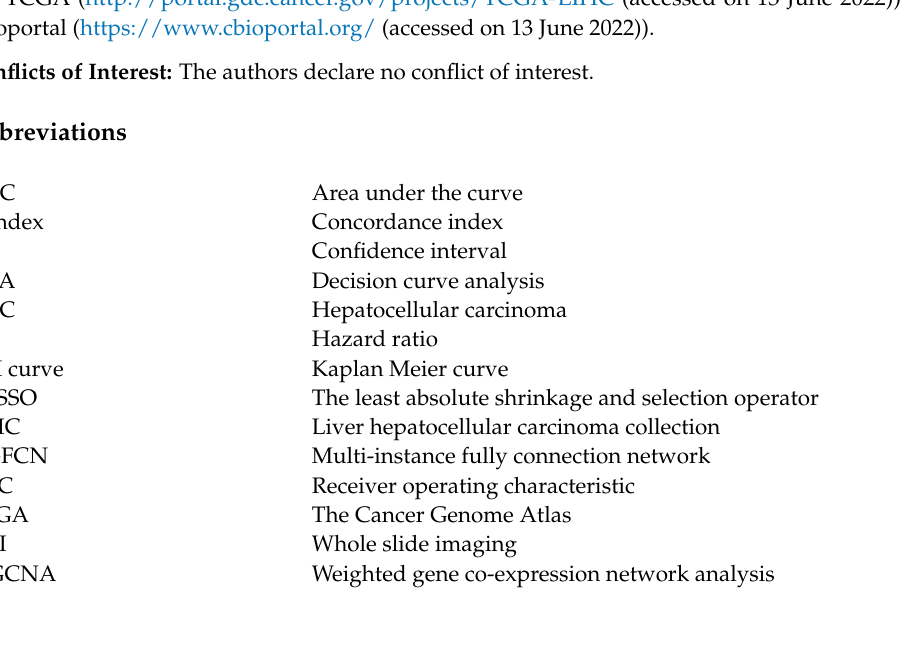
Table S6. The 8 co-expressed gene modules generated by